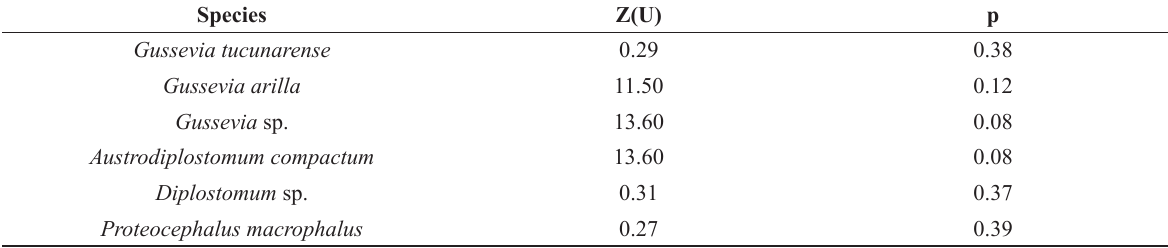
Effect of the sex of Cichla ocellaris Bloch & Schneider, 1801 collected in the Jacaré-Pepira River, State of São Paulo, Brazil, in relation to the parasite abundance of each parasite